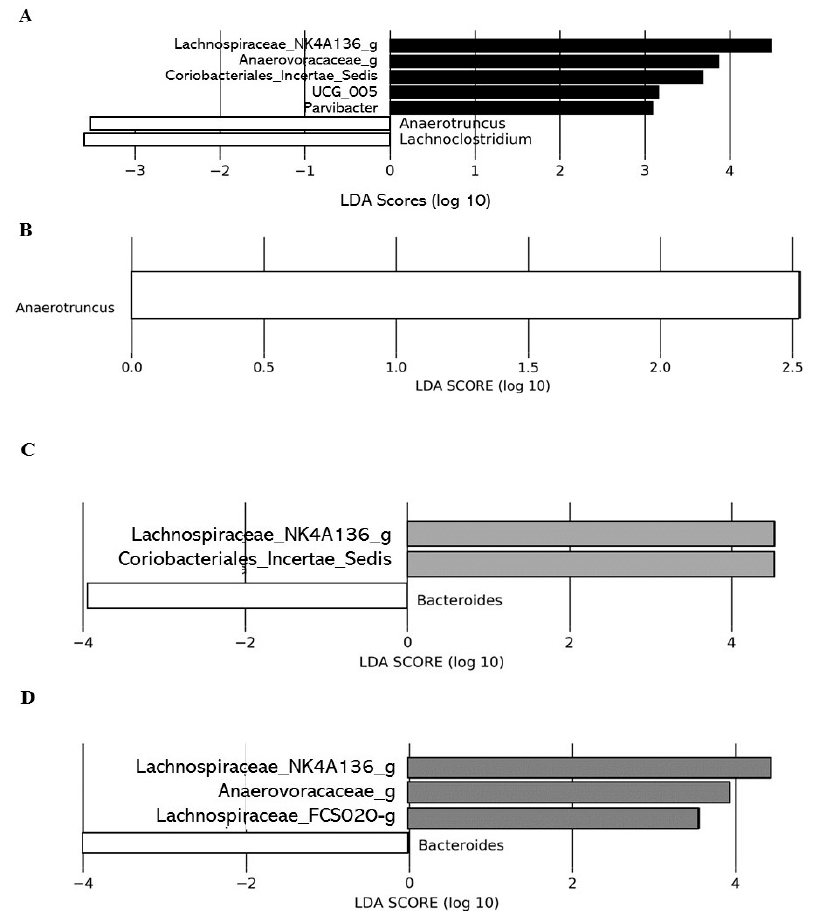
Figure 4. Administration of the different DCJs is associated with changes in the gut microbial of mice in comparison with the control (water). The linear discriminant analysis (LDA) effect size was calculated in order to explore the taxa within genus levels that more strongly discriminated between the gut microbiota of mice treated with ( A ) water (white) and 0% DCJ (dark), ( B ) water and 40% DCJ (light grey), ( C ) water and 60% DCJ (medium grey), and ( D ) water and 80% DCJ (dark grey). Families followed by the label ‘-g’ indicate unidentified genera.